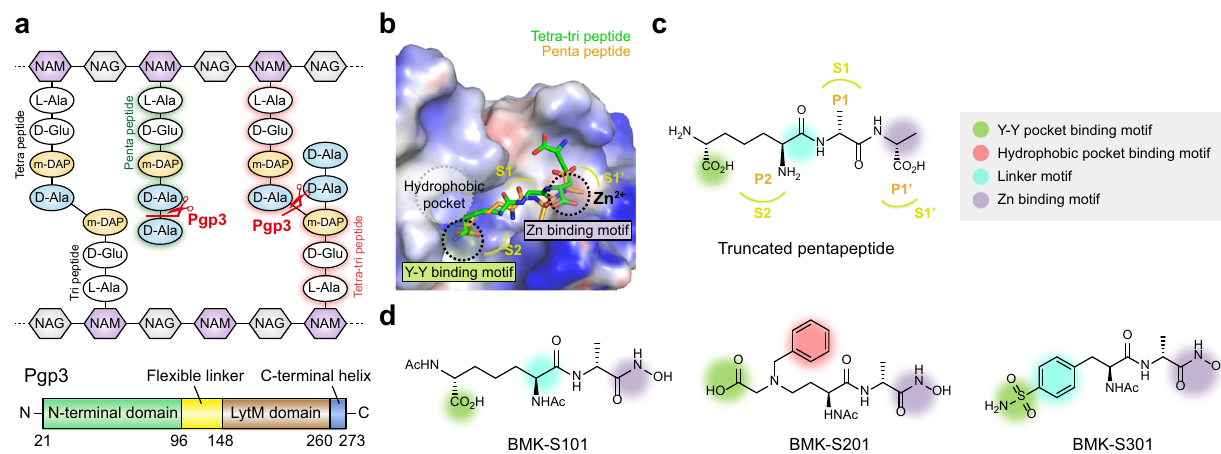
Fig. 1 Structure-based design of Pgp3 inhibitors. a Schematic diagram of peptidoglycan structure and domain architecture of Pgp3. Cleavage sites by Pgp3 are shown with scissors. b Surface representation of the electrostatic potential of Pgp3 in complex with tetra-tripeptide and pentapeptide (PDB ID: 6JN0 and 6JN1, respectively). Tetra-tripeptide and pentapeptide are shown in green and orange sticks, respectively. Representative motifs are shown in dashed circles. Substrate binding pocket (S1 ’ , S1, and S2) are colored in lime. c Chemical structure of truncated pentapeptide (mDAP 3 -D-Ala 4 -D-Ala 5 ). Green, red, purple, and cyan circles indicate the Y – Y binding motif, hydrophobic pocket binding motif, Zn binding motif, and linker motif, respectively. Substrate- speci fi c binding residues (P1 ’ , P1, and P2) and substrate binding pockets (S1 ’ , S1, and S2) are colored in orange and lime, respectively. d Chemical structure of synthesized inhibitors. BMK-S101 was designed in keeping of Zn binding motif, linker motif, and Y – Y binding motif based on pentapeptide. In BMK-S201, additional binding in hydrophobic pocket was introduced, whereas the rigidity was modulated in BMK-S301 by inserting the linker motif.